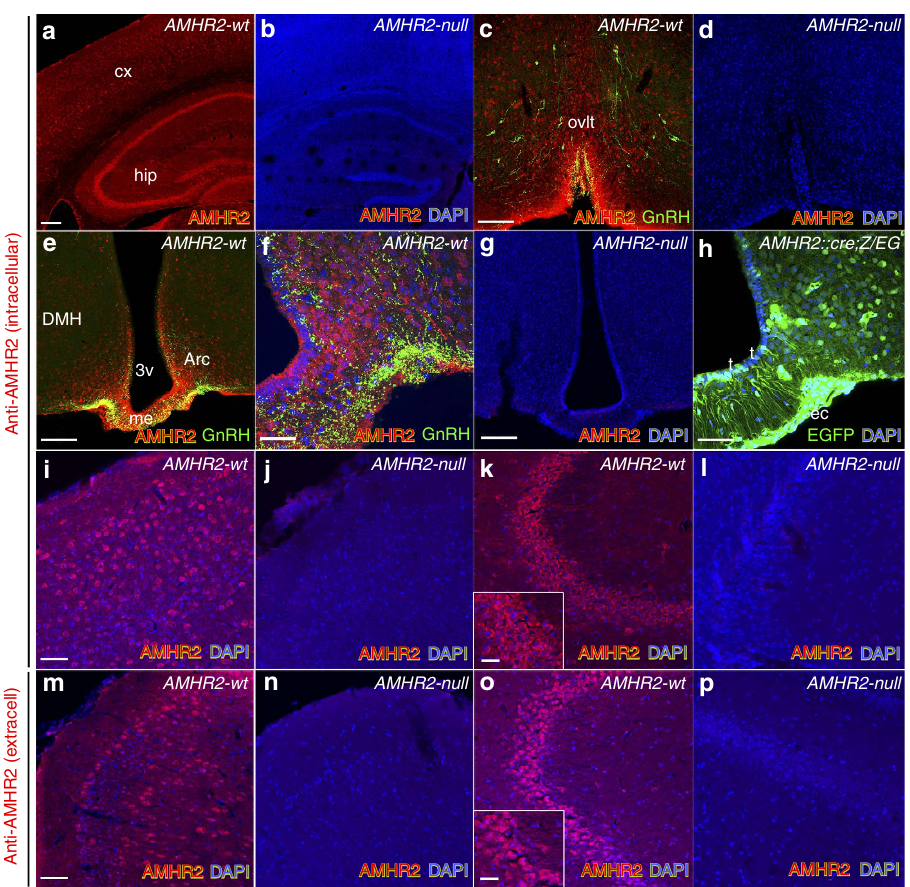
Figure 1 | Specificity tests of anti-AMHR2 antibody and identification of AMHR2-expressing cells in the adult mouse brain. ( a – p ) Coronal sections immunolabelled with the indicated antibodies, from AMHR2::Cre þ / þ (AMHR2-wt, number of immunostained P120 female brains, n ¼ 5) and AMHR2:: Cre (cid:2) / (cid:2) (AMHR2-null, number of immunostained P120 female brains, n ¼ 5). AMHR2 expression was also analysed in AMHR2::Cre þ / (cid:2) ;Z/EG reporter line ( h ; number of immunostained P60 female brains, n ¼ 3). The vector of Z/EG mouse line was designed to provide lacZ expression before Cre excision and EGFP expression after Cre excision and is referred to as Z/EG (lacZ/EGFP) 23 . AMHR2 expression was found in the cortex ( a , i , m ), dentate gyrus of the hippocampus ( a , k , o ), organum vasculosum of the lamina terminalis (OVLT; c ) hypothalamic median eminence (me) and dorsomedial hypothamaus (DMH) arcuate nucleus (Arc; e , f , h ). Moreover, AMHR2-expressing cells were found in hypothalamic tanycytes (t) lining the third ventricle (3V) and endothelial (EC) cells ( f , h ). Brains of AMHR2-null mice were totally depleted of AMHR2 immunoreactivity when using an antibody against an intracellular epitope of the AMHR2 ( b , d , g , j , l ) or an antibody against the extracellular region of the receptor ( n , p ). Experiments were replicated at least three times. Scale bars, ( a , b ) 200 m m; ( c – e , g ) 100 m m; ( f , h ) 25 m m; ( i – p ) 40 m m (inset in k and o ). DAPI, 4 0